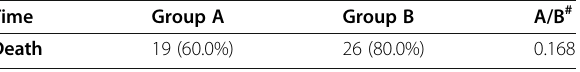
Table 7 Comparison between case and control groups as regards creatinine (mg/dL)